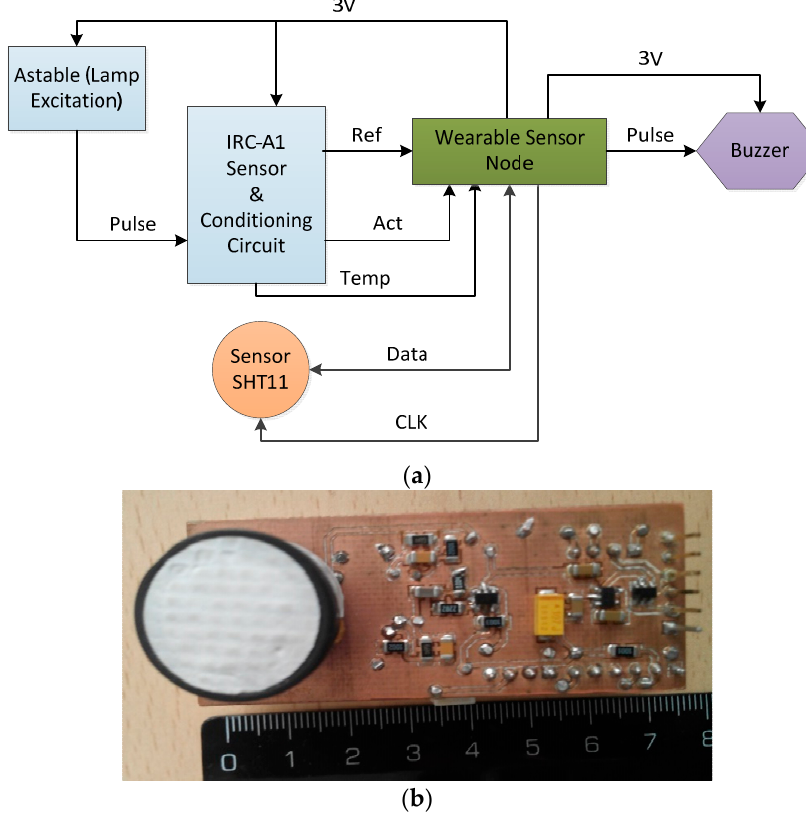
Figure 3. Sensor board and node connection: ( a ) block diagram; ( b ) photograph.